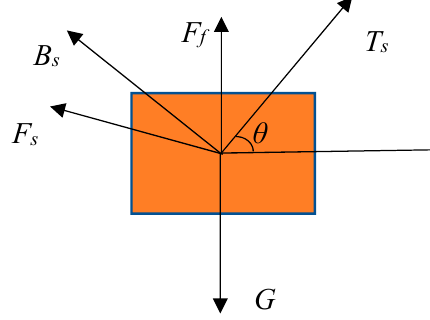
Figure 3. The force diagram of the subsea tree.